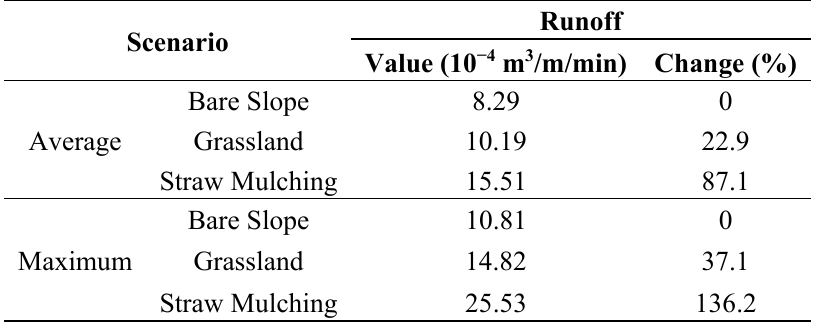
Table 3. Difference value and change of the groundwater runoff and volume in three